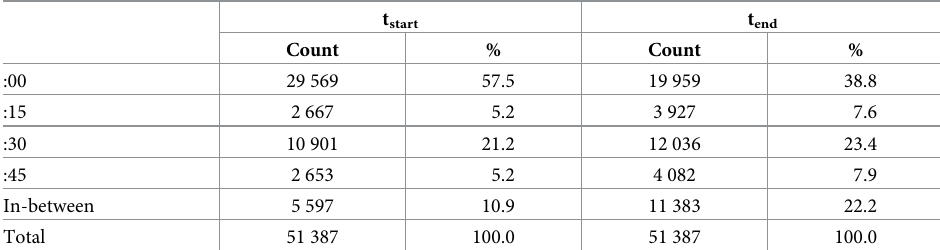
Table 4. Start and end times (by minutes) of apartment burglaries of the entire dataset of apartment burglaries in Vienna,